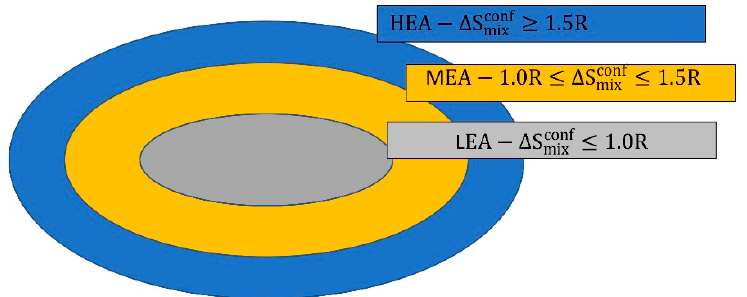
Figure 1. Classification of the alloys according to the configurational entropy of mixing [8].